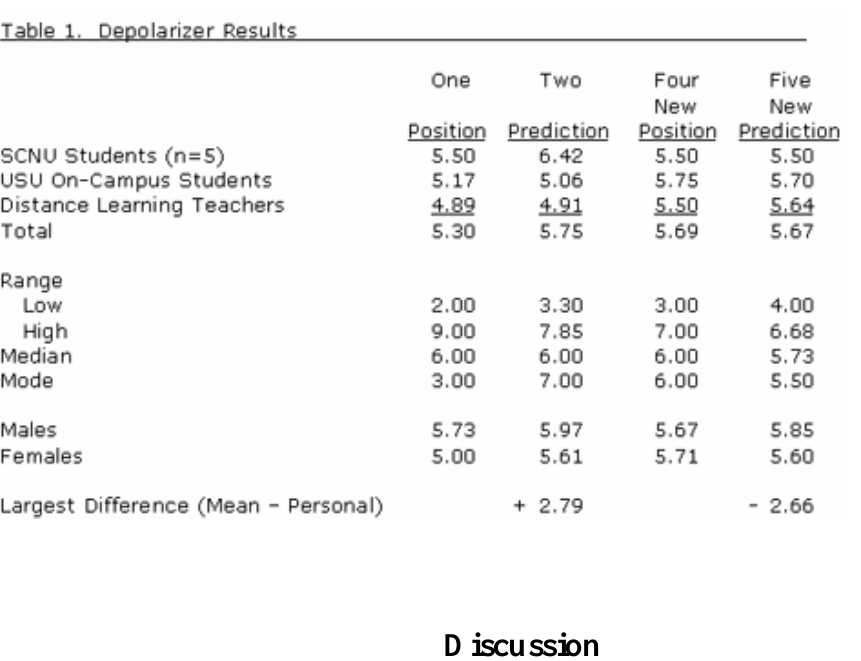
Table 1. Depolarizer